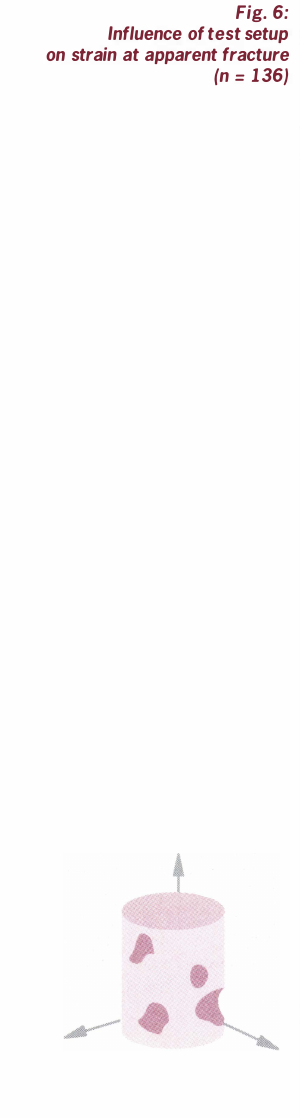
Fig. 6: Influence of test setup on strain at apparent fracture (n = 136}